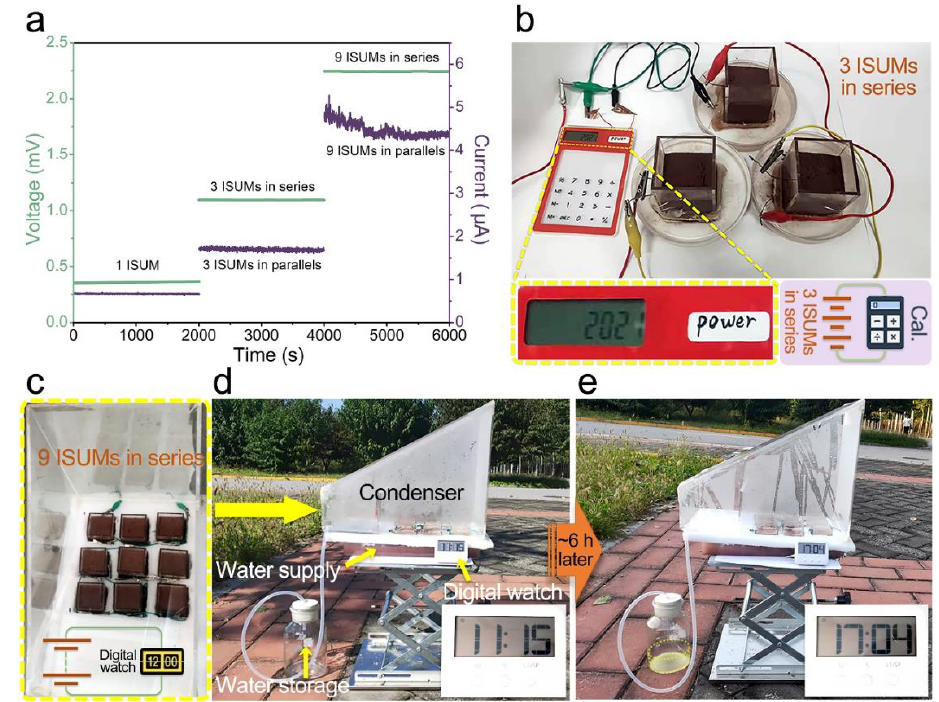
Figure 5. ( a ) Induced voltages and currents of 1, 3, 9 ISUMs composed of rocky land in series and parallel connection; ( b ) Integrated 3 ISUMs can power an electronic calculator; ( c ) The top view